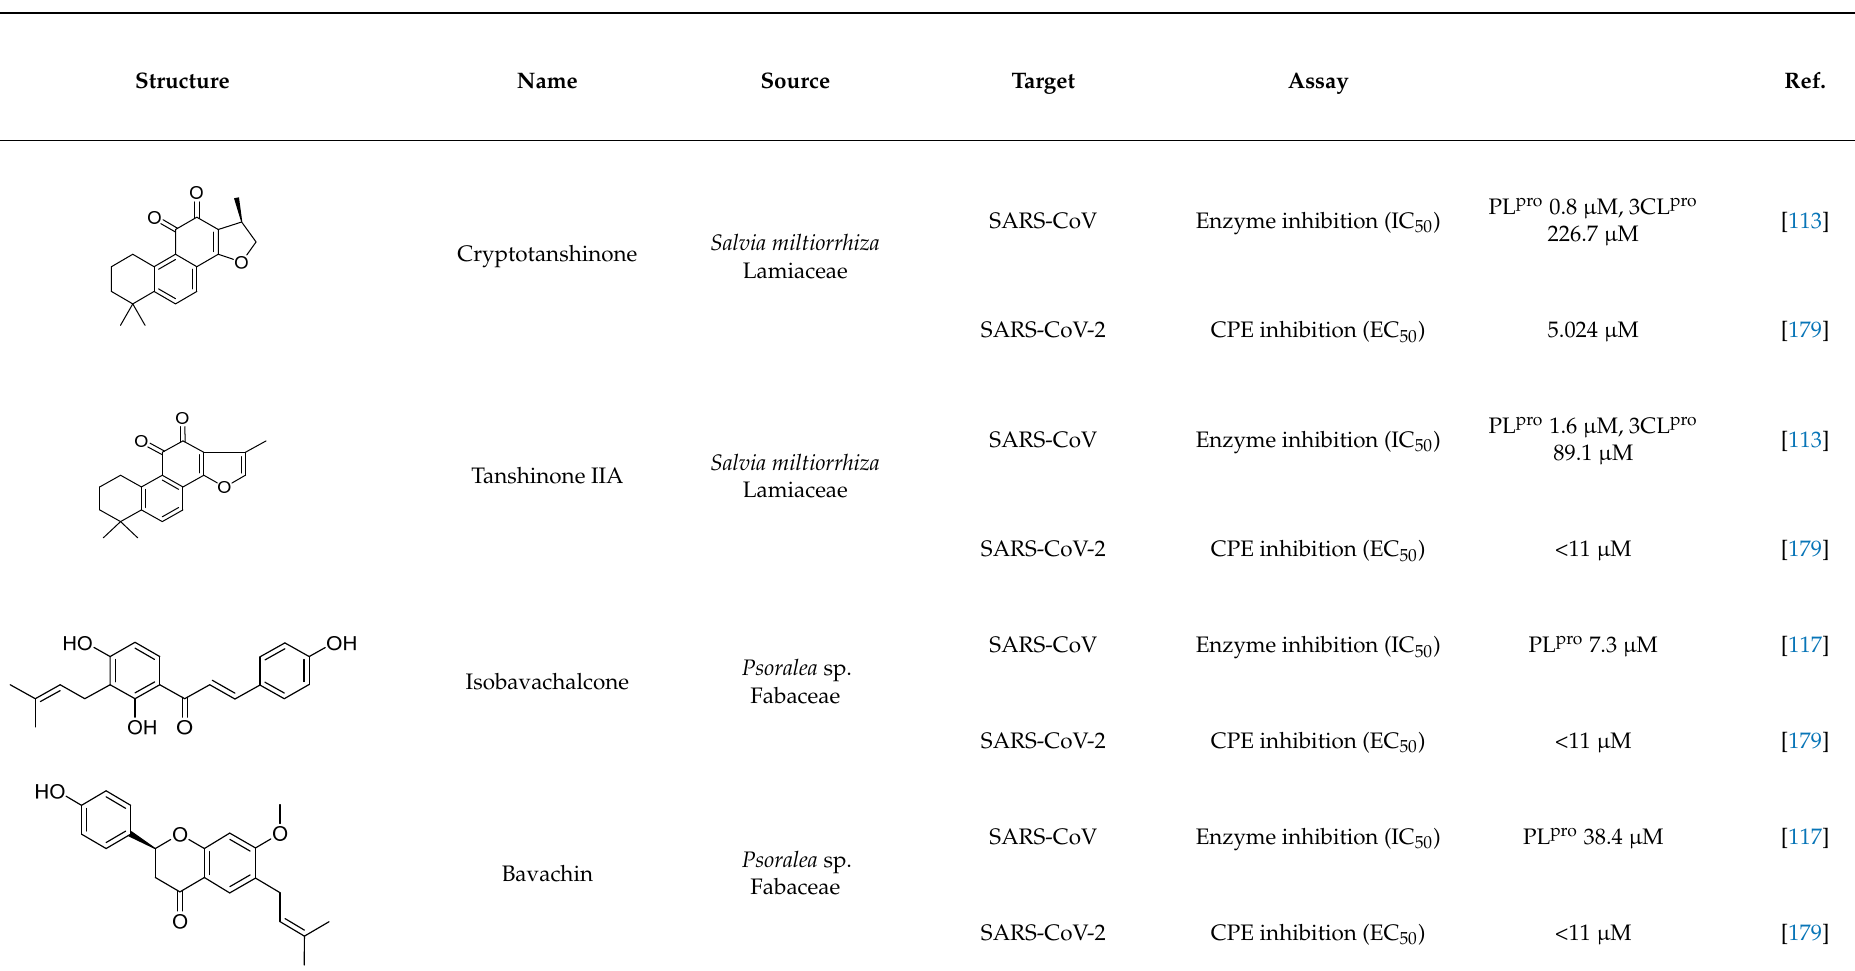
Table 1. Antiviral activity of selected NPs against HCoV-NL63, HCoV-OC43, MERS-CoV, SARS-CoV, and